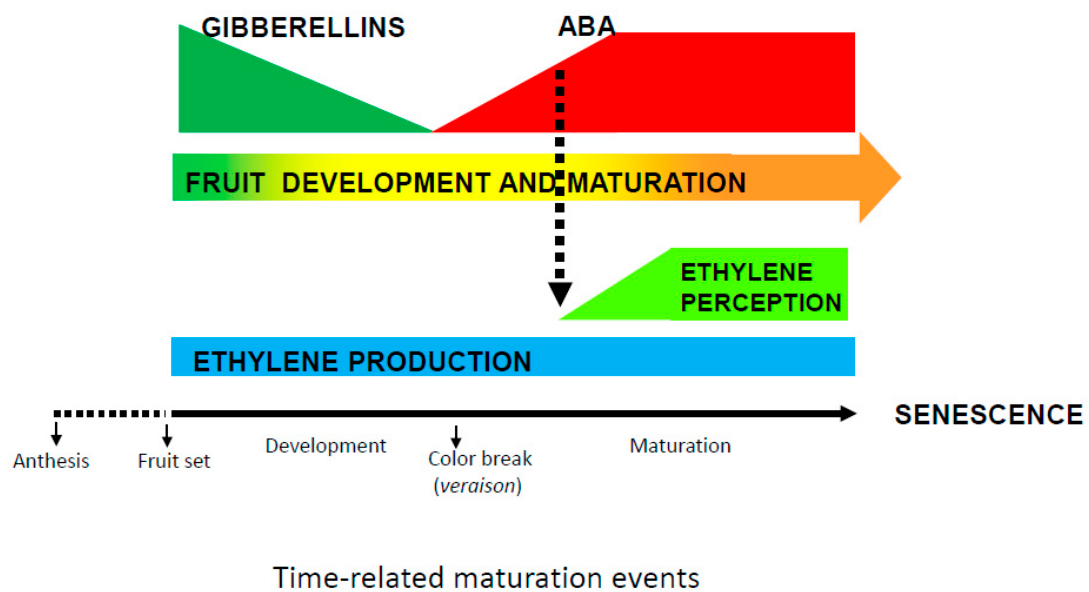
Figure 2. A time-course model of the interplay between abscisic acid (ABA) and gibberellins (GAs) in modulating non- climacteric fruit development and maturation. This is a reductionistic model, as other players involved are not depicted. These include nutritional and environmental factors. The shape of the elements in the figure illustrates the evolution of each component during fruit maturation. GAs decrease, ABA increase and ethylene production remains steady, whereas ethylene perception increases. The crosstalk with ethylene (dash line pointing an induction in ethylene perception driven by ABA) remains to be demonstrated.